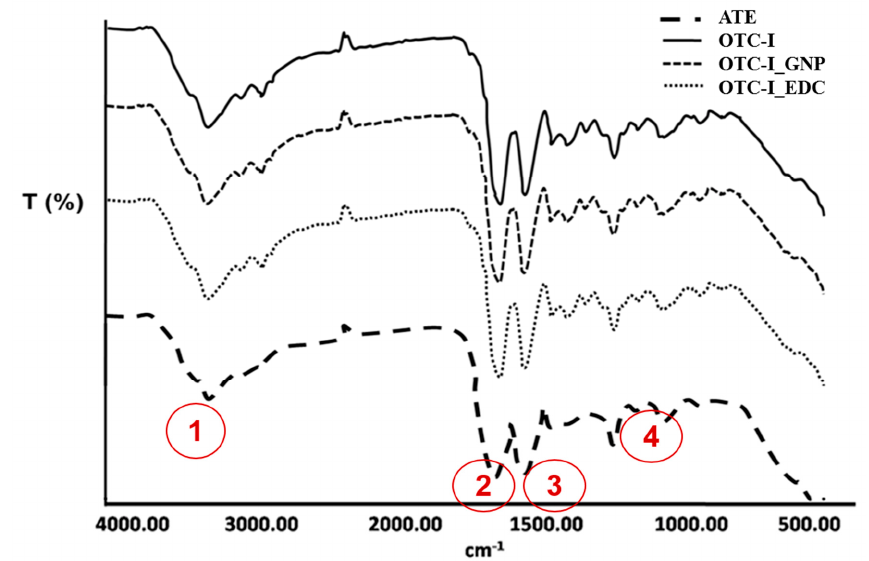
Figure 3. Chemical characterization of collagen bioscaffold via Fourier transformation infrared (FTIR).